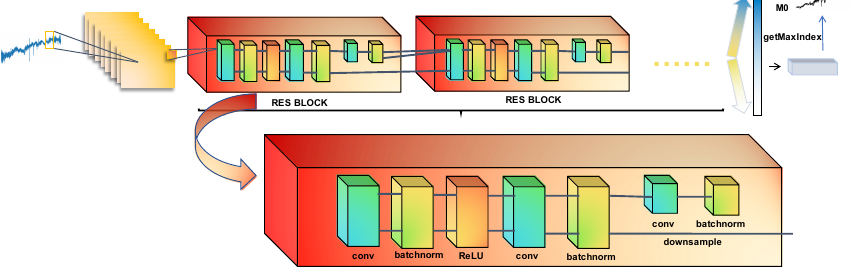
Figure 9. The network structure of ResNet.